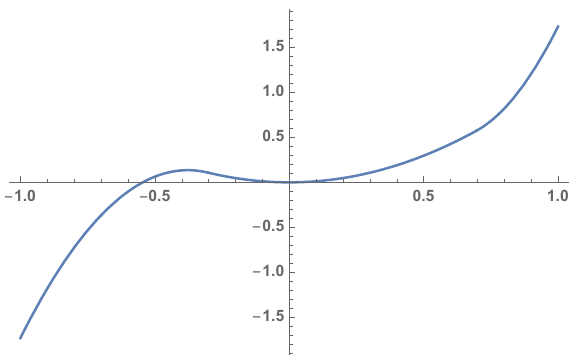
Figure 2 . The function ~ f ( x ) for a chiral (cid:12)eld Y in the Y 2 ; 1 quiver gauge theory [41], with R-charge p (cid:1) (cid:0) r = 1 3 13 (cid:0) 9 ’ 0 : 3